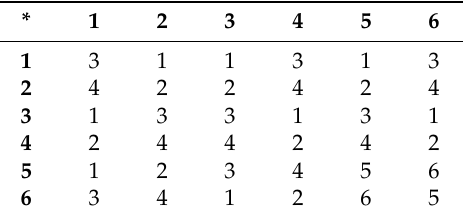
Table 6. Non-commutative